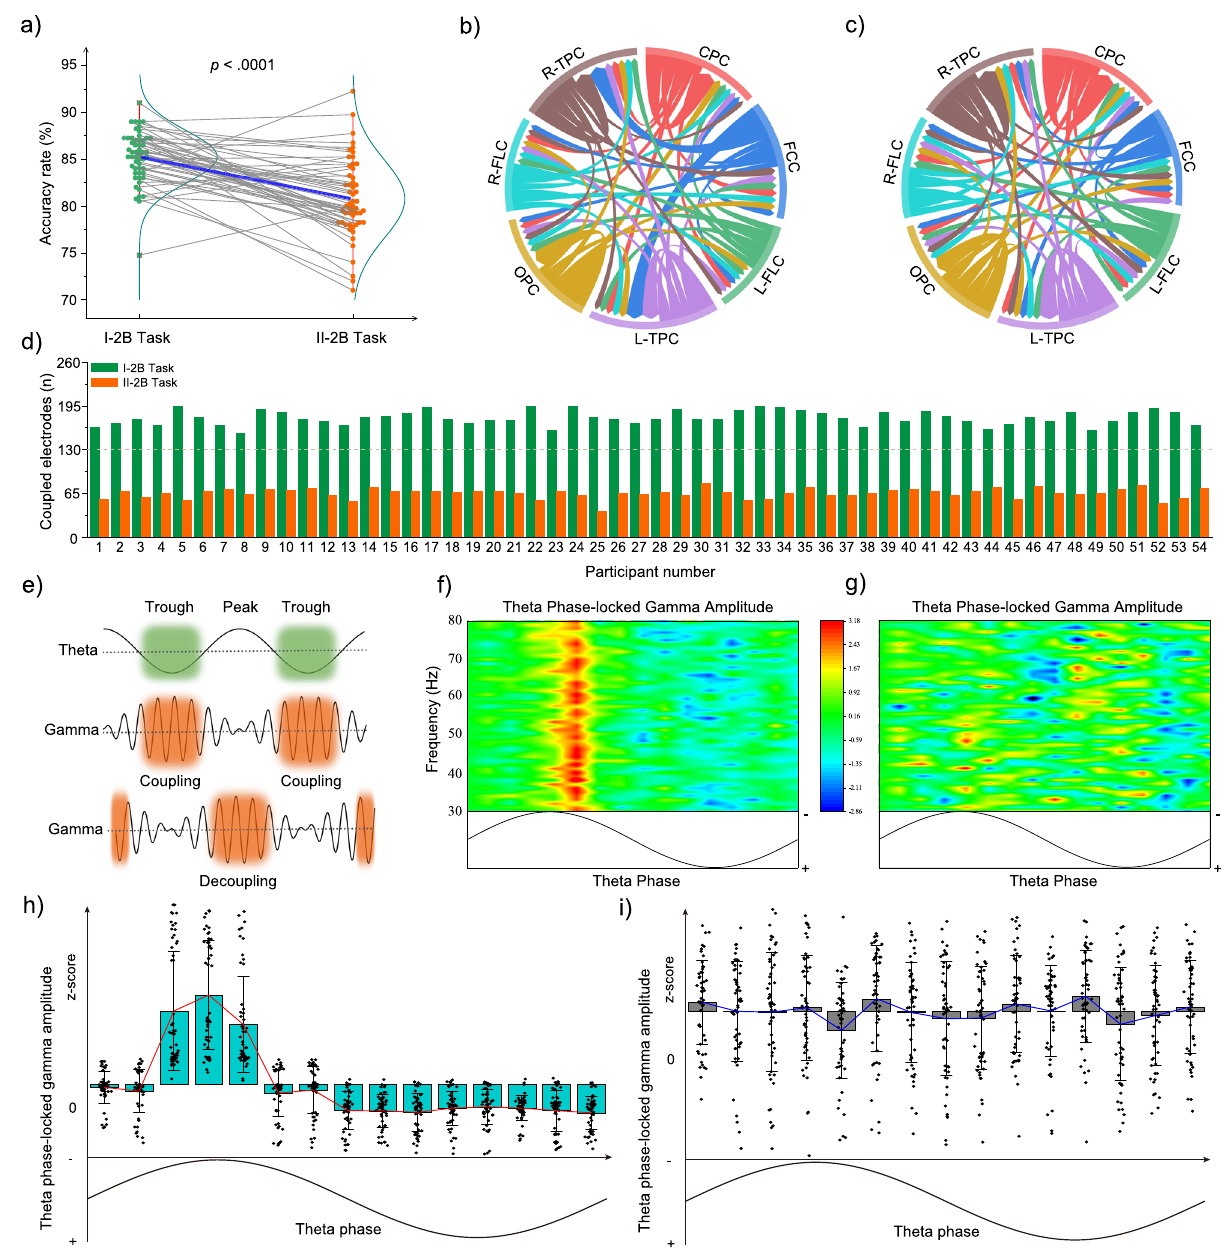
Fig. 2 Results of the lengthy mental task. n = 54, a after the lengthy mental task, behavior performance, the mean accuracy rate of the two-back task, was signi fi cantly declined indicated by a one-way repeated ANOVA. I-2B and II-2B tasks represented the two-back tasks before and after the lengthy mental task, respectively. b The chord diagram of the I-2B task from the ergodic analysis shows electrode clusters in the temporal-parietal cortex (TPC) surface having a great majority of gamma-amplitude modulation by theta phase obtained from electrode clusters in the frontal-central cortex (FCC) surface. c During the II-2B task, this cross-structure phase-amplitude coupling (PAC) was decoupled after the lengthy mental, indicated by the change in the thickness of the connecting lines. d The number of coupled electrodes signi fi cantly reduced for each participant compared to before the lengthy mental task. Green represented the I-2B task, and orange represented the II-2B task. e A challenging working memory such as the mental manipulation of a two- back task will require maximal allocation of cognitive resources, which is achieved by alignment of frontal-central and temporal-parietal neural fi ring, enabled by nesting TPC gamma activity into the excitatory trough of FCC theta phase. However, this coupled phase position removes from the trough after the length mental task, and it is improbable that much neural communication between the frontal-central and temporal-parietal cortex occurs in this condition. f Instantaneous amplitude values for frequencies >30 Hz from a TPC electrode were locked to the negative peak of a theta cycle from an FCC electrode. g This phenomenon disappeared after the lengthy mental task. h Cyan bars (means ± standard deviations) further indicated that the theta phase in FCC surface signi fi cantly modulated gamma amplitude in terms of the average state in TPC surface for the I-2B task. i This phenomenon disappeared in the II-2B task, indicated by grey bars (means ± standard